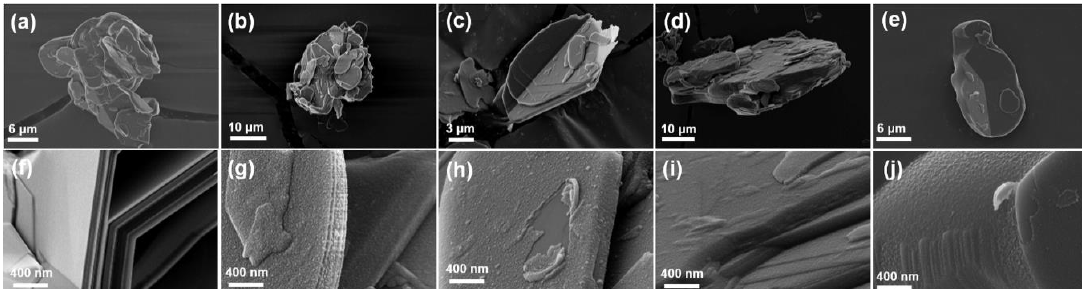
Figure 1. FE-SEM images of ( a , f ) raw boron nitride (BN), ( b , g ) heat-treated BN coated with PDA (polydopamine) (BNPDA), ( c , h ) BNPDA particles heated to 400 °C (BNPDA-400), ( d , i ) BNPDA particles heated to 800 °C (BNPDA-800), ( e , j ) BNPDA particles heated to 1000 °C (BNPDA-1000).